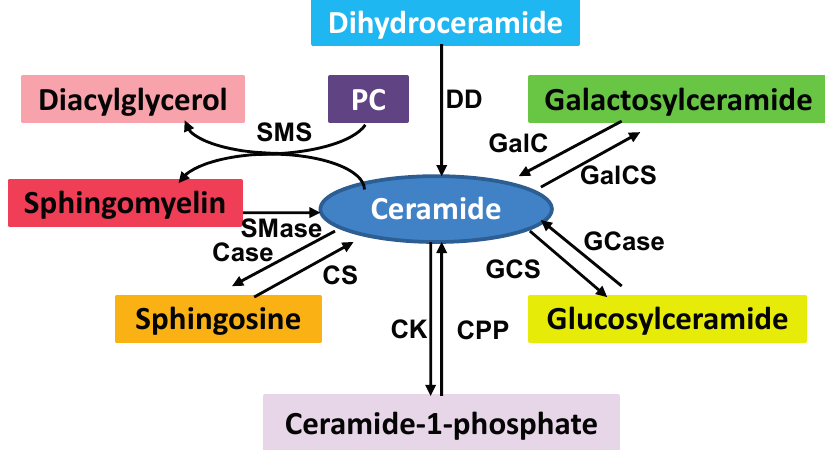
Figure 2. Sphingolipid metabolism. Ceramide is a key intermediator in sphingolipid metabolism. The enzymes involved in sphingolipid metabolism are ceramidase (Case), ceramide kinase (CK), ceramide-1-phophosphate phosphatase (CPP), ceramide synthase (CS), dihydroceramide desaturase (DD), galactosylceramide synthase (GalCS), galactocer (GalC), glucosylceramide synthase (GCS), glucosylceramidase (Gcase), sphingomyelinase (Smase), and sphingomyelin synthase (SMS). Many of these products play an important role in cell signaling which regulates a variety of cellular functions. SMS converts phosphatidylcholine (PC) and ceramide to sphingomyelin and diacylglycerol which brings two major classes of lipids in cell metabolism and